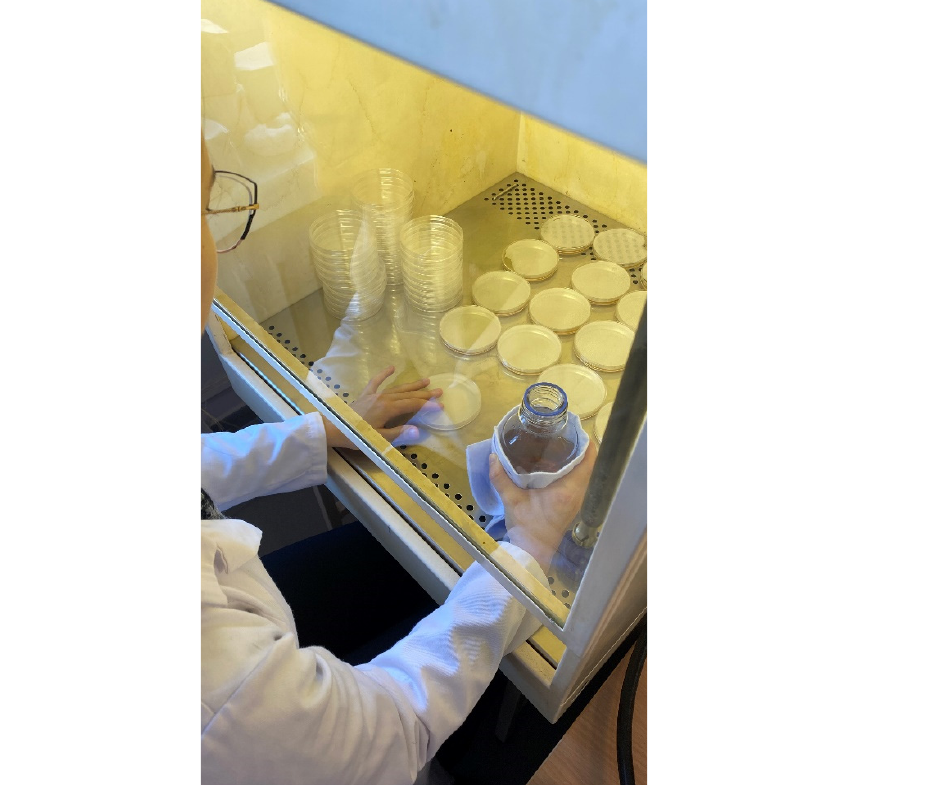
Figure 2. Trichoderma spp. isolates on Petri dishes.